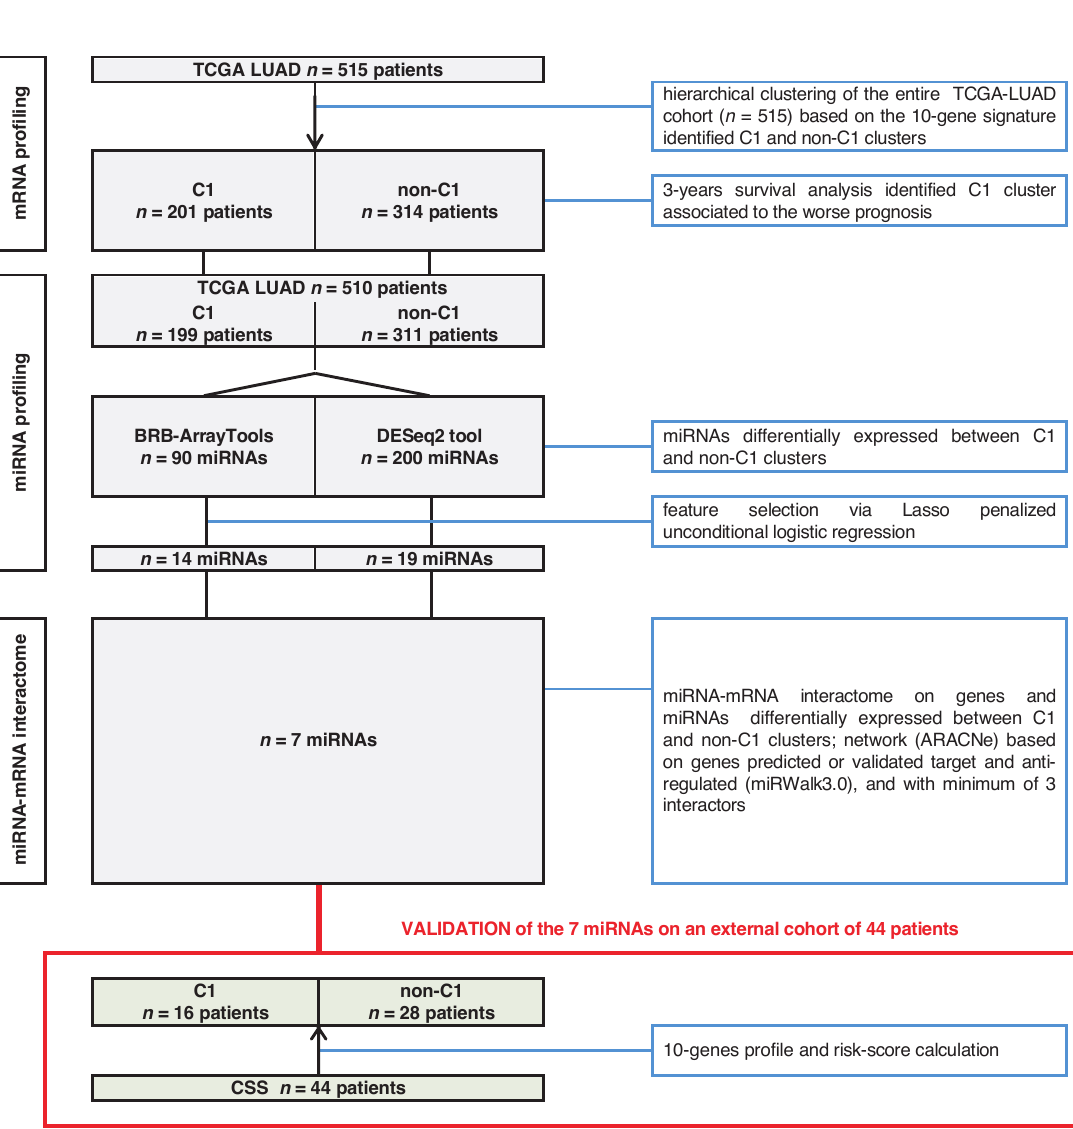
Figure 1. Flow chart of study design with data sets and